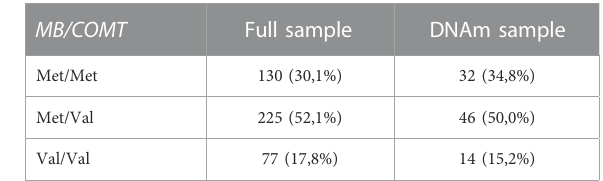
TABLE 1 Genotype frequencies of MB-COMT Val158Met.